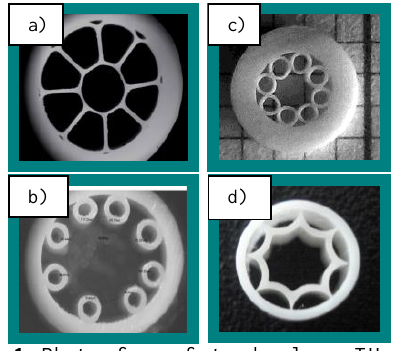
Fig. 1. Photo of manufactured polymer THz waveguides